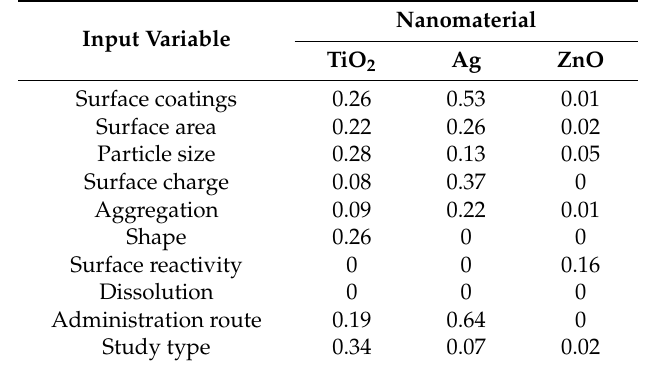
Table 3. Sensitivity analysis of BN model. Entropy reduction indicates the degree to which NM hazard was sensitive to each input nodes of the model. Higher values signify higher sensitivity of the NM hazard mode to the input node.